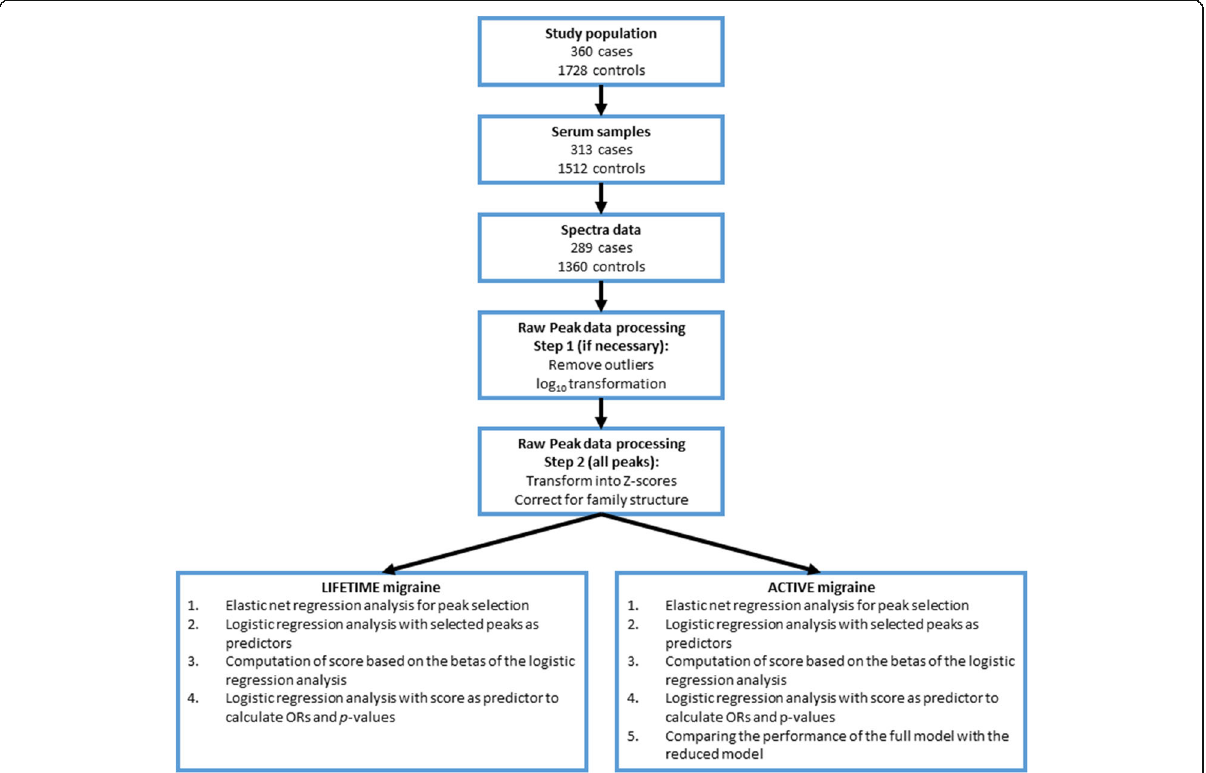
Fig. 1 Flow chart of the patient flow and analysis steps